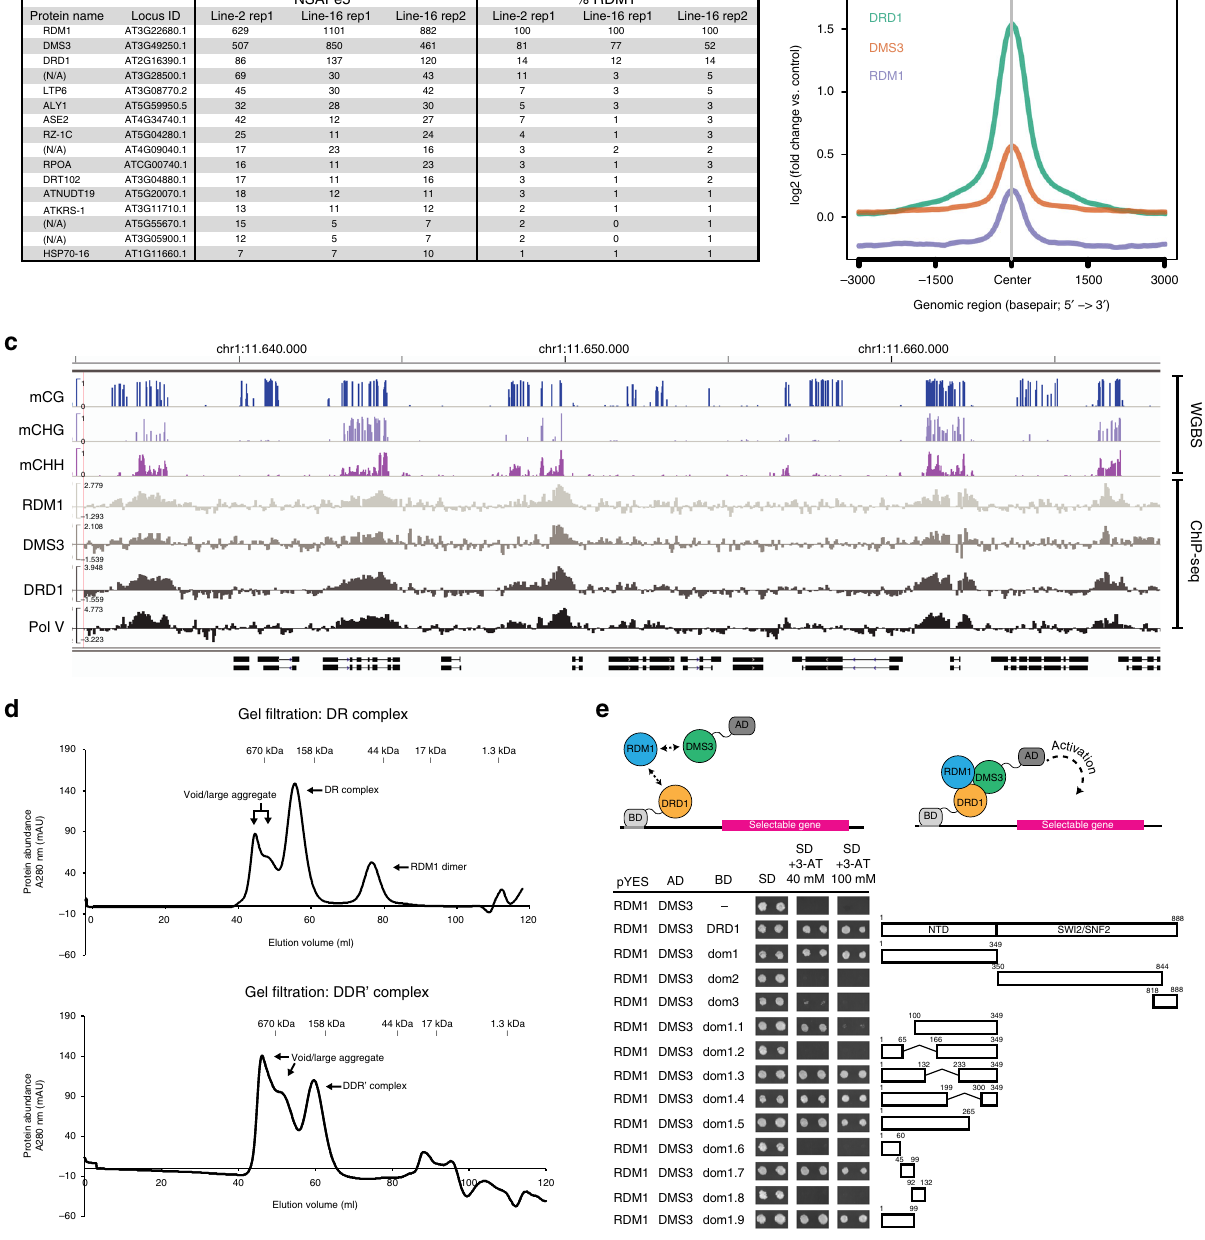
Fig. 1 DMS3, RDM1, and DRD1 form complexes in vivo and in vitro. a List of proteins co-puri fi ed with RDM1 identi fi ed by mass spectrometry (MS). Only proteins present in all three independent IP experiments using RDM1-3xFLAG lines but absent in two independent IP experiments using untransformed WS control are shown. Normalized spectral abundance factor value (NSAF× 10 5 ) 59 is indicated for each protein. Estimated stoichiometry is shown as the percentage of RDM1 using NSAF values. All proteins except for the RDM1, DMS3 and DRD1 are common contaminants present in different IP-MS experiments performed in our laboratory. N/A is denoted when protein name not available. b Metaplot showing DRD1, DMS3 and RDM1 ChIP-seq signals over Pol V peaks. c Representative screenshot of a genomic region showing CG, CHG and CHH methylation levels from WGBS in wild-type control 31 , as well as ChIP-seq signals of RDM1, DMS3, DRD1 and Pol V, expressed as log 2 ratio over controls. d Gel fi ltration analyses of His tag af fi nity-puri fi ed DR complex (top) or Strep II tag af fi nity-puri fi ed DDR ′ complex (bottom) showing that both complexes are stable and isolatable from E. coli . Protein molecular weight marker is indicated above each pro fi le. Peaks eluted around 670 kDa represent void/large aggregate and will not be further characterized. e Y3H experiment showing interactions of the DMS3-RDM1 complex with different DRD1 fragments. Upper panel: explanatory cartoon of Y3H technique. BD: GAL4 binding domain fusion, AD: GAL4 activation domain fusion. pYES: expression plasmid under a constitutive ADH1 promoter. Growth of two independent colonies in minimal medium (SD) supplemented with increasing concentrations of 3-amino-1,2,4-triazole (3-AT) is shown. Cartoon depicting the length of the different DRD1 fragments tested is shown on the right. Numbers above each fragment indicate the position of the fi rst and last amino acid with respect to full-length DRD1. N-terminal domain (NTD) and SWI2/SNF2 domain are